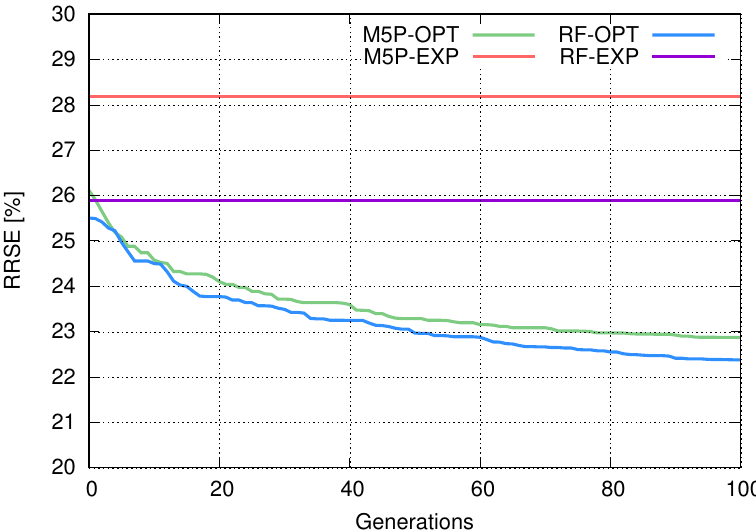
Figure 8. Roughness prediction error (RRSE) estimates for regression trees, random forests and the expert-defined setting. Error estimates for the optimized regression trees and random forests are averaged over ten runs and marked with suffix “OPT”. Error estimates for the expert defined setting are marked with “EXP”. For details see Section